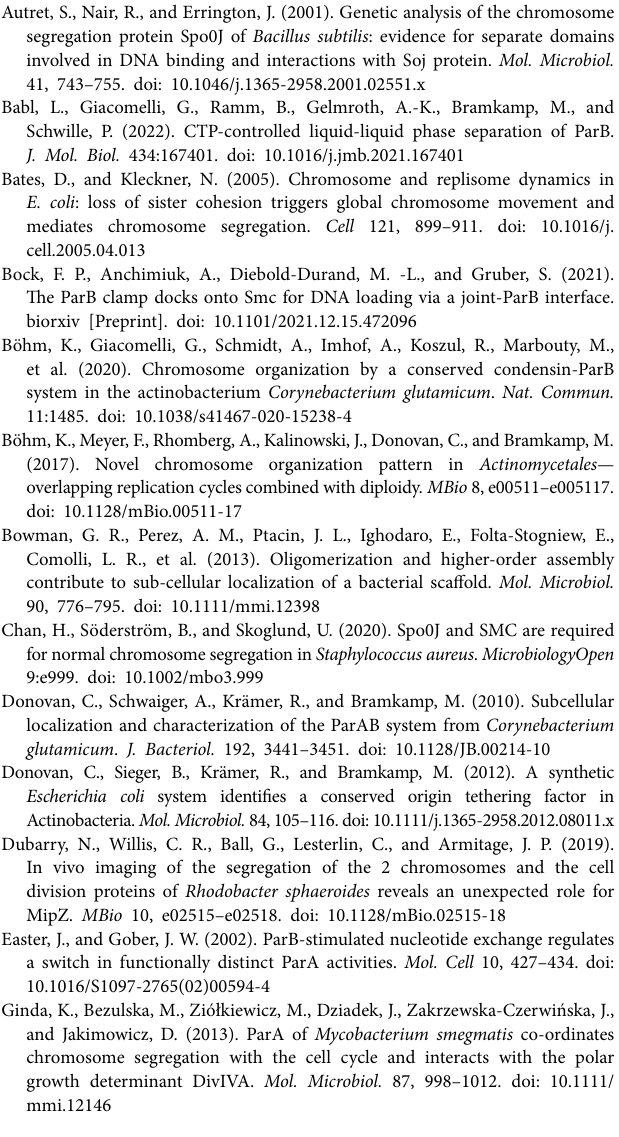
Mycobacterium smegmatis (ParA Ms ) parA genes or R. sphaeroides parA1 (ParA Rs ) with and without induction with vannilate. Florescence images of MipZ-YPF fluorescence (yellow) merged with DIC. C. crescentus strain MT97 served as a control. Scale bar 2 μ m. Supplementary Figure S3 | Confirmation of ParA proteins production in Mycobacterium smegmatis and Corynebacterium glutamicum strain. (A) Western blot analysis of M. smegmatis Δ parA strains overexpressing own (Ms) and heterologous parA from C. glutamicum (Cg). Δ parA strain and mc2 served as controls. Strains were cultured overnight with 10% acetamide induction (marked as +) or without ( − ). Cells were lysed by sonication and 100 μ g of total proteins were subjected to 10% SDS-PAGE electrophoresis and then transferred on nitrocellulose blotting membrane. The membrane was incubated with rabbit serum containing anti ParA Ms antibody. As secondary antibody anti-rabbit IgG conjugated with alkaline phosphatase was used. Prestained protein ladder (Thermo Scientific) was used as a marker (marked as M). (B) Western blot analysis of cell lysate from C. glutamicum Δ parA strains complemented with own